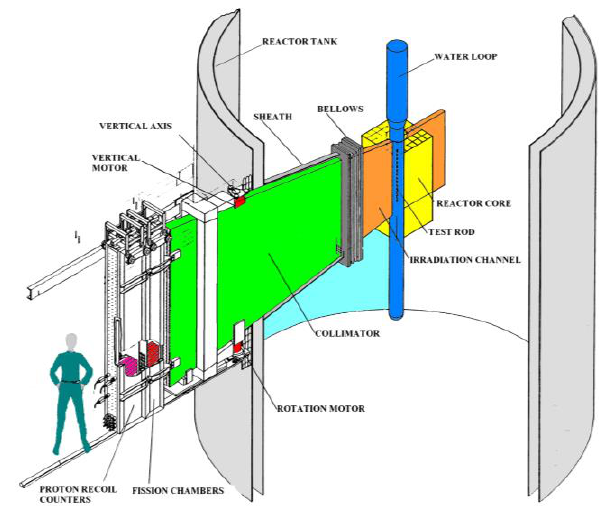
Fig. 2. Hodoscope detector system.